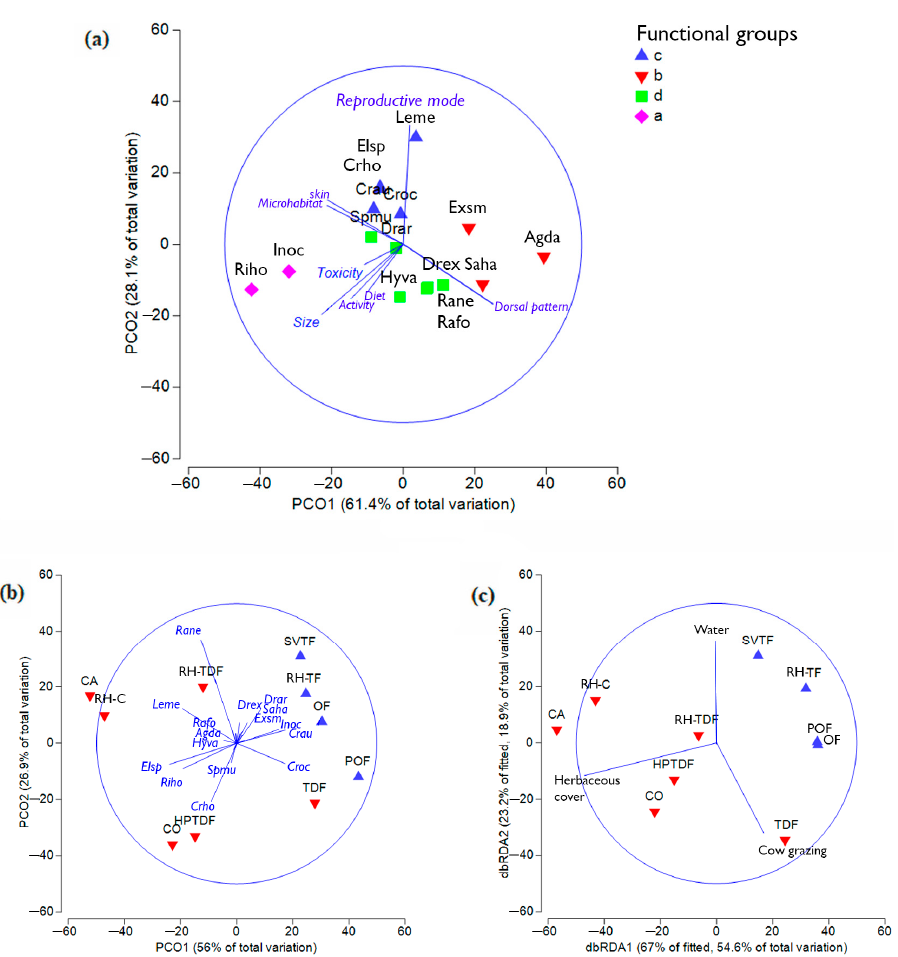
Figure 3. PCO and dbRDA ordinations. ( a ) PCO ordination shows functional traits per amphibian species and functional groups; ( b ) The relationship between amphibian species composition and land cover/use types; ( c ) dbRDA ordination shows the relationship between environmental predictors that best explained the amphibian community variation across land cover/use types. Codes: sugar cane field (CA), riparian habitat surrounded by crops (RH-C), cornfield (CO), highly perturbated tropical dry forest (HPTDF), tropical dry forest (TDF), riparian habitat surrounded by tropical dry forest (RH-TDF), riparian habitat surrounded temperate forest (RH-TF), secondary vegetation surrounded by temperate forest (SV-TF), oak forest (OF) and pine-oak forest (POF). Craugastor hobartsmithi (Crho), Craugastor occidentalis (Croc), Craugastor augusti (Crau), Eleutherodactylus sp. (Elsp), Incilius occidentalis (Inoc), Rhinella horribilis (Riho), Exerodonta smaragdina (Exsm), Dryophytes arenicolor (Drar), Dryophytes eximius (Drex), Sarcohyla hapsa (Saha), Leptodactylus melanonotus (Leme), Hypopachus variolosus (Hyva), Agalychnis dacnicolor (Agda), Rana aff . forrieri (Rafo), Rana neovolcanica (Rane), Spea multiplicata (Spmu). Tropical habitats are represented in red and temperate habitats are shown in